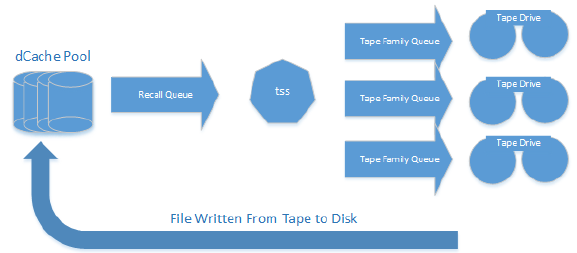
Figure 4: Queuing System from dCache to